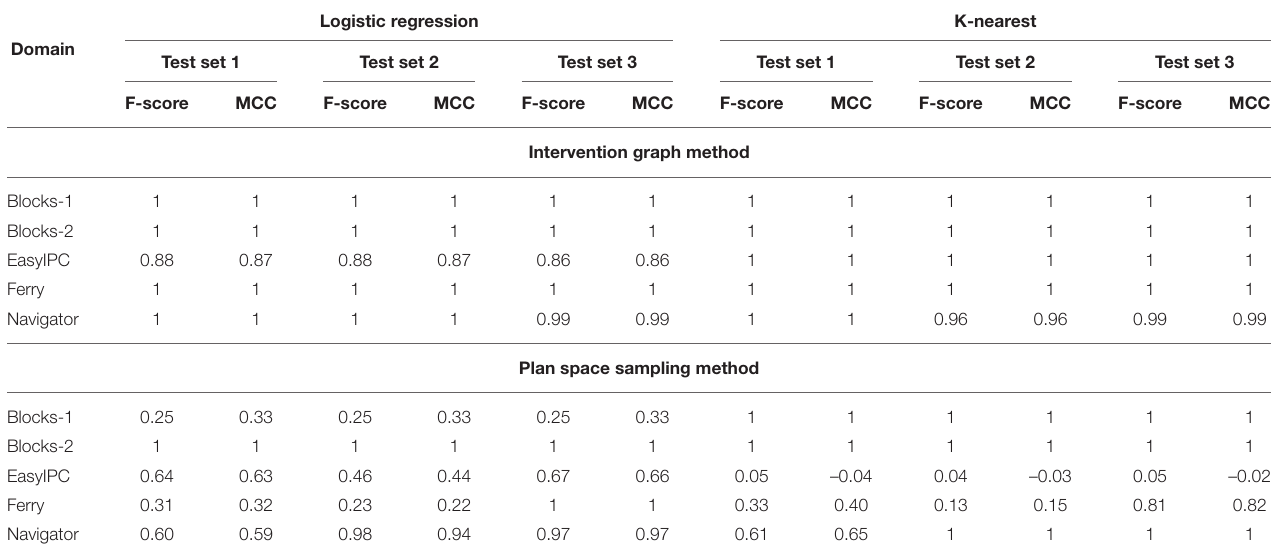
TABLE 4 | F-score and MCC for predicting intervention using Intervention Graph and Plan Space Sampling methods for logistic regression and k-nearest neighbor